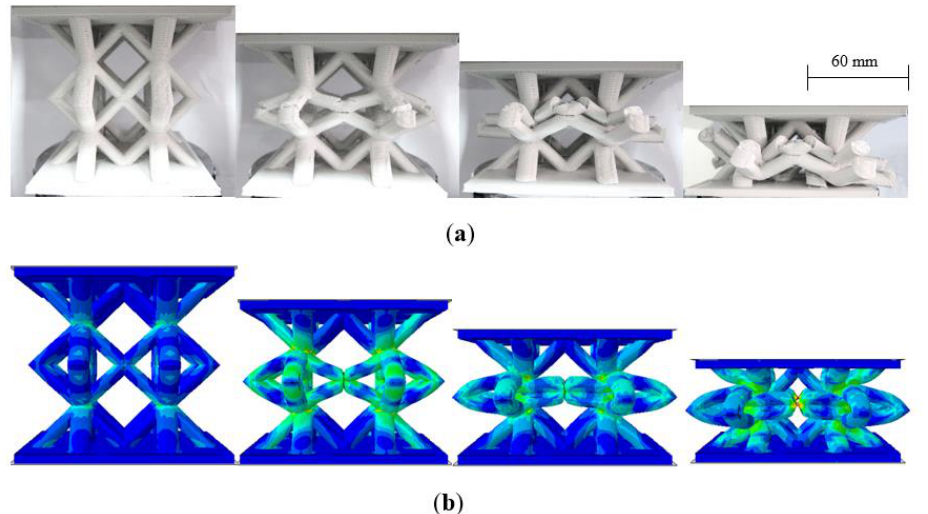
Figure 15. Comparison of ( a ) the experimentally observed and ( b ) the predicted failure modes in the largest (n = 1) lattice structure.